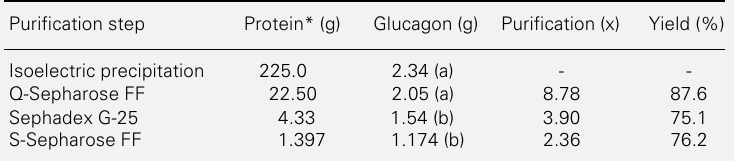
Figure 4 - Analytical characteriza- tion of glucagon by HPLC. A , Puri- fied glucagon (Fr C from S- Sepharose FF). B , Standard gluca- gon. Purified and standard gluca- gon have the same retention time (10.97 ± 0.08) and approximately the same purity (84.05 and 85.2% for purified and standard gluca- gon, respectively). Experimental conditions: after sample applica- tion, a stepwise acetonitrile gra- dient consisting of 50, 60, 62, 70 and 80% buffer “B” (5 min per step) was used (buffer “A”, 50 mM sodium phosphate, 10 mM perchloric acid, pH 2.5, and buffer “B”, 50% acetonitrile in buffer “A”) in an Aquapore RP 300 col- umn (4.6 x 250 mm) at room tem- perature and at a flow rate of 1 ml/min. The elution was moni- tored by absorbance at 214 nm. Figure 5 - Hyperglycemic action of glucagon on mice. Circles, Con- trol (without glucagon); triangles, purified glucagon (Fr C from S- Sepharose FF); squares, standard glucagon. The mice (fasted fe- males weighing 18 to 25 g) were divided into three groups (8 mice per group), which received by subcutaneous injection 2.5 µg of purified glucagon (Fr C from S- Sepharose), standard glucagon or saline solution. Forty-µl blood samples were taken and centri- fuged and plasma glucose was determined by the method of Barhan and Trinder (16). Each point represents the means of